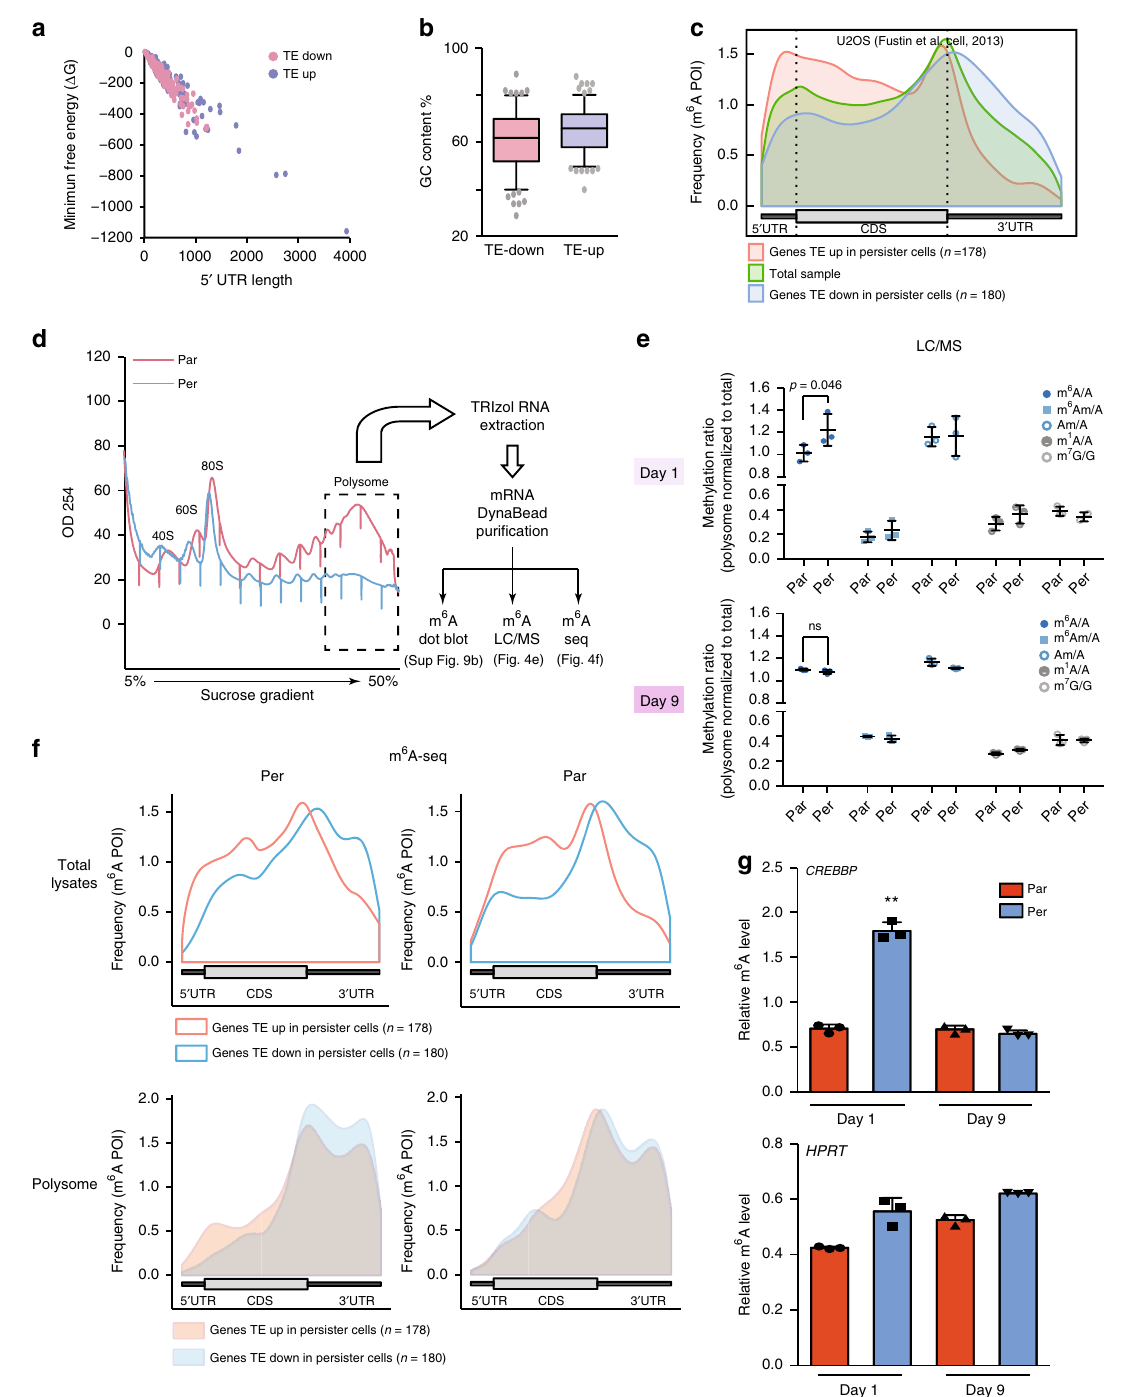
Preventing m 6 A methylation synergizes with BRAFi/MEKi . persister cell-derived colonies compared with scramble shRNA